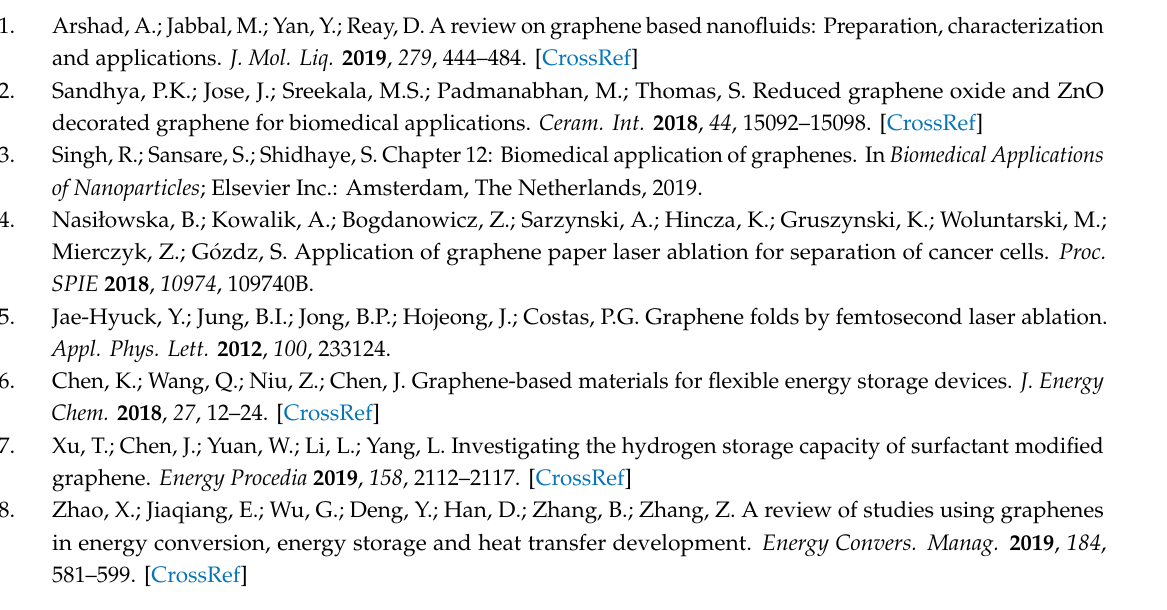
Figure S1: LIBS (Laser Induced Breakdown Spectroscopy) spectrum of the graphene paper, Figure S2: Raman spectrum of graphene paper for laser wavelength equal to 532 nm (a) and position of Raman measurement (b), Figure S3: The FTIR spectrum of graphene